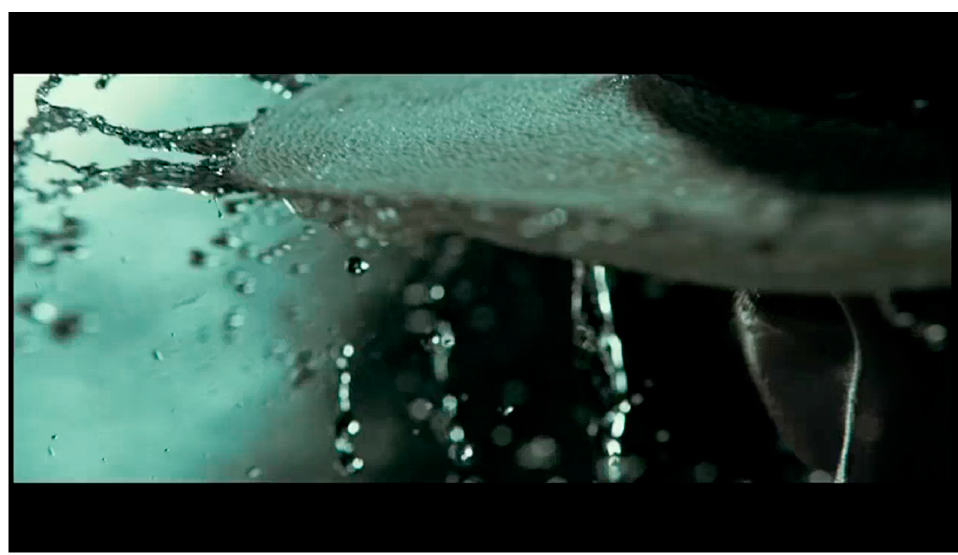
Figure 15. Obscured behind torrents of driving water. Frame capture, The Grandmaster (Wong 2013).